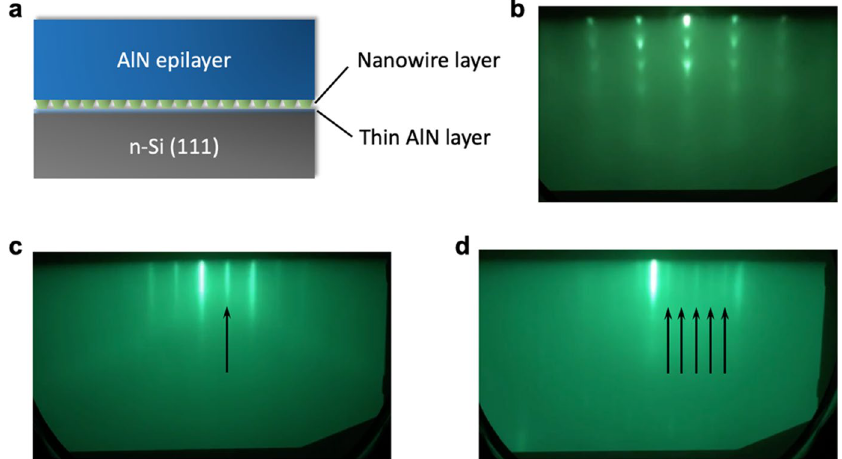
Figure 1. ( a ) Schematic of the growth of the AlN epilayer on Si substrate using a nanowire-based template. ( b ) RHEED pattern taken during the growth of the nanowires. ( c , d ) RHEED patterns taken along the < 1120 > direction and < 1100 > direction, respectively, during the growth of the AlN epilayer. The arrows reflect the 2 × 6 RHEED